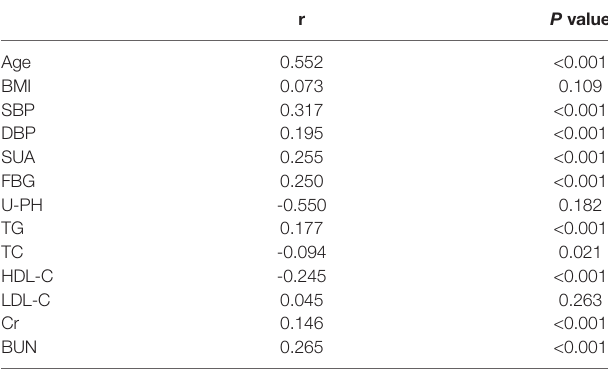
TABLE 2 | Correlation analysis of CIMT with general data and biochemical indexes.